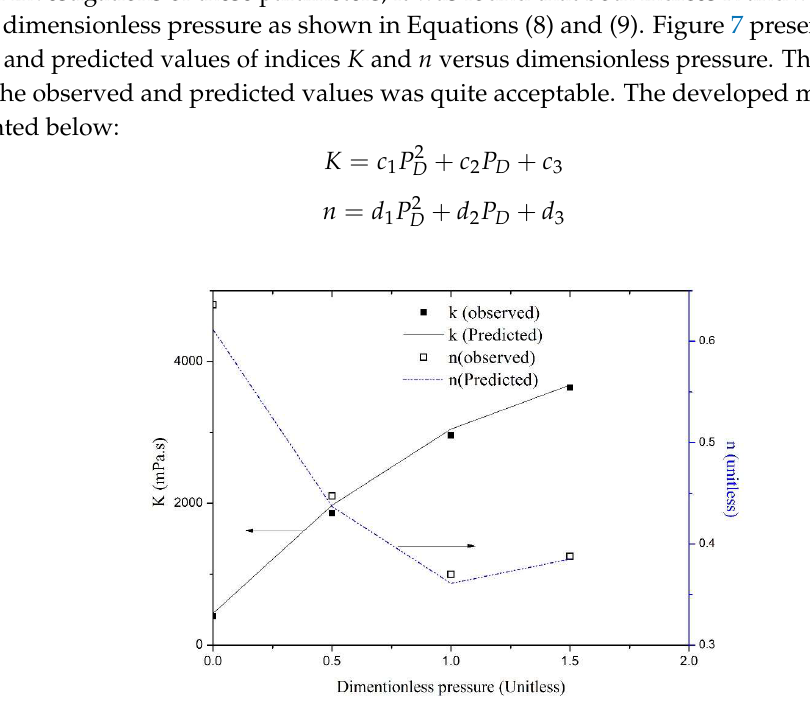
Figure 7. Effect of dimensionless pressure on the power law indices ( K and n ) of sCO 2 foam.